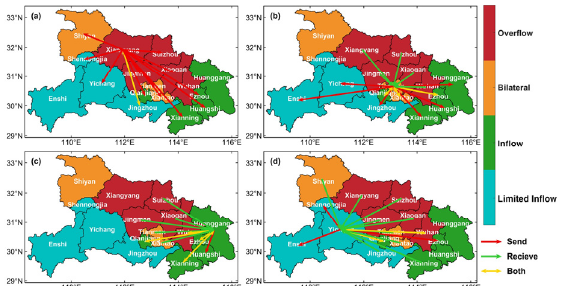
Figure 5. PM 2.5 overflow effects in four typical cities: (a) Xiangyang (Overflow type); (b) Tianmen (Bilateral type); (c) Huanggang (Inflow type); (d) Yichang (Limited inflow